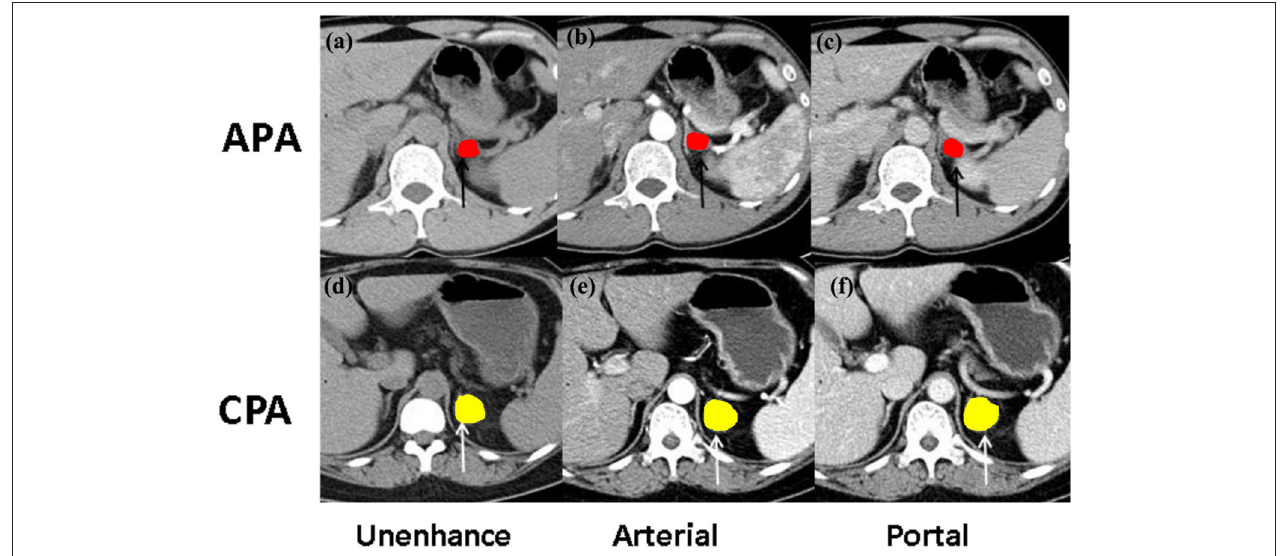
FIGURE 3 | The illustration of ROI selection. (a) The Unenhanced and contrast-enhanced CT images at (b) the arterial phase and (c) portal phase of CT imaging findings in a 46-year-old woman with aldosterone-producing adenoma (APA, black arrow); (d) the unenhanced and contrast-enhanced CT images at (e) the arterial phase and (f) portal phase of CT imaging findings in a 39-year-old man with cortisol-producing adenoma (CPA, white arrow).